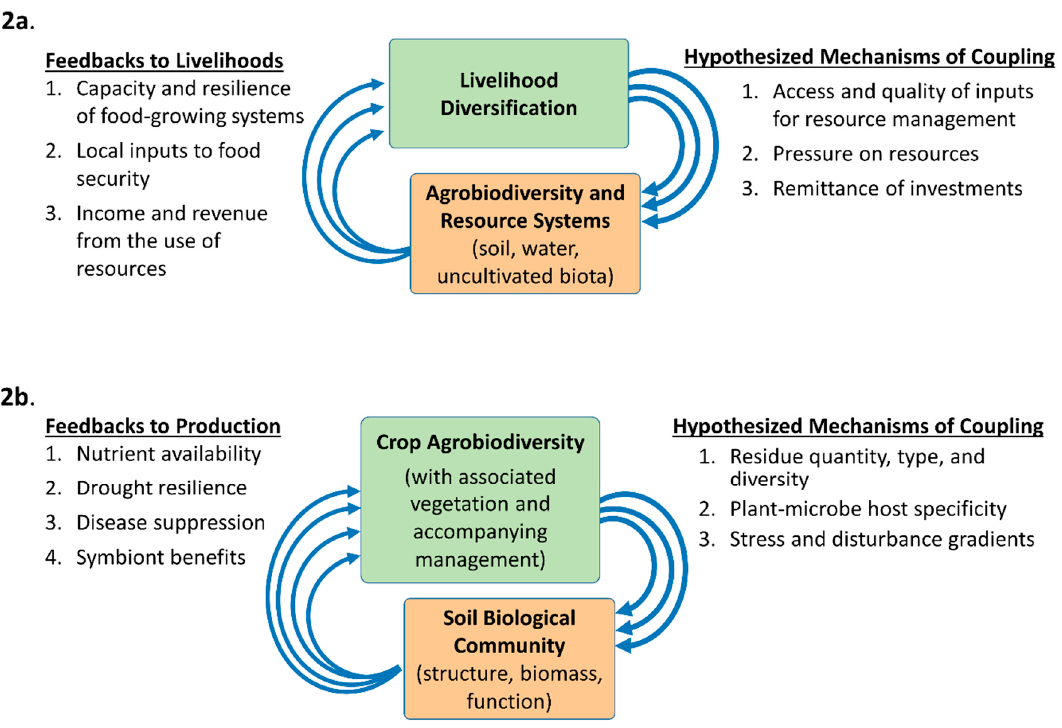
Figure 2. ( a ) Coupling of the interactions of livelihood diversification and agrobiodiversity and ( b ) the above- and belowground components of agrobiodiversity.